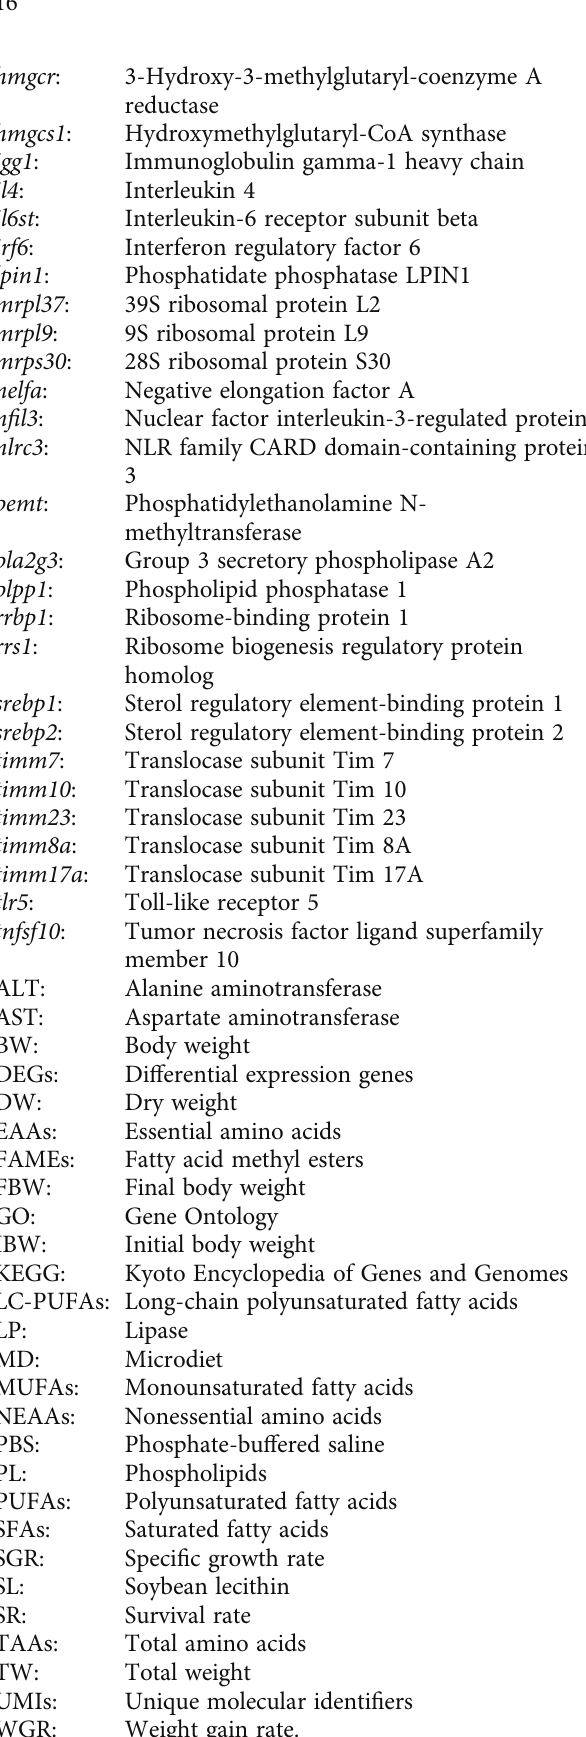
Table S1: formulation and nutrient analysis of microdiets (MD). Table S2: primers used for qRT – PCR validation. Table S3: basic information for the RNA sequencing data and map- ping. Table S4: All DEG list. (Supplementary